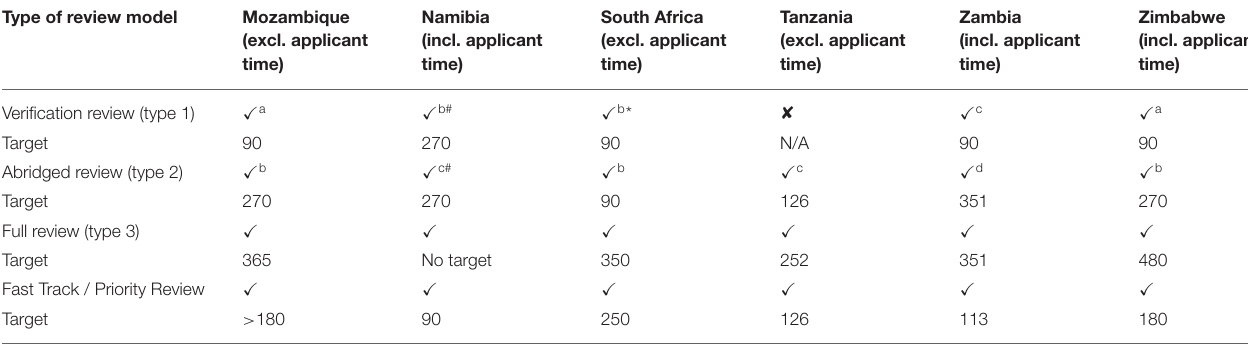
TABLE 3 | Review models employed and target timelines (calendar